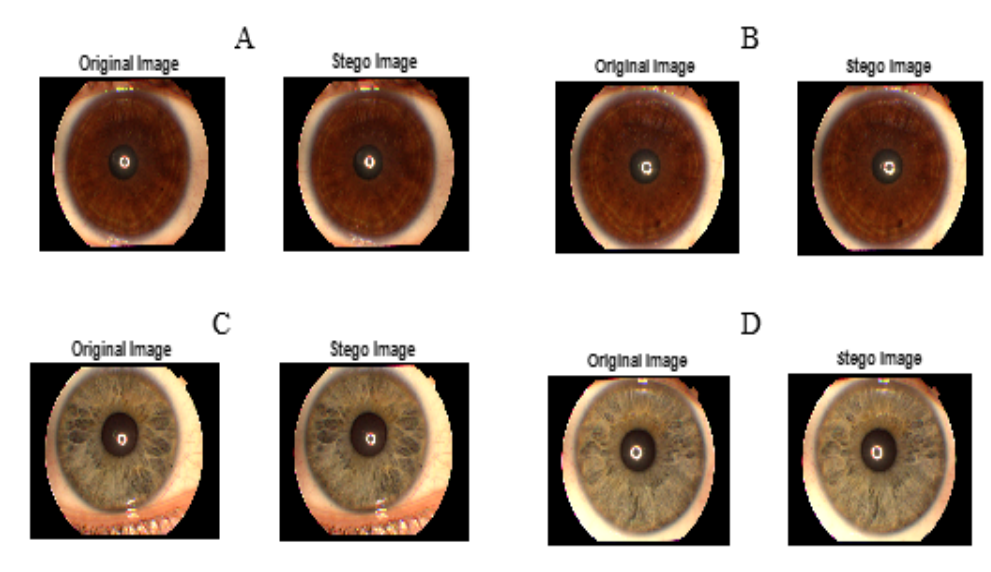
Figure 4. Original and steganography image